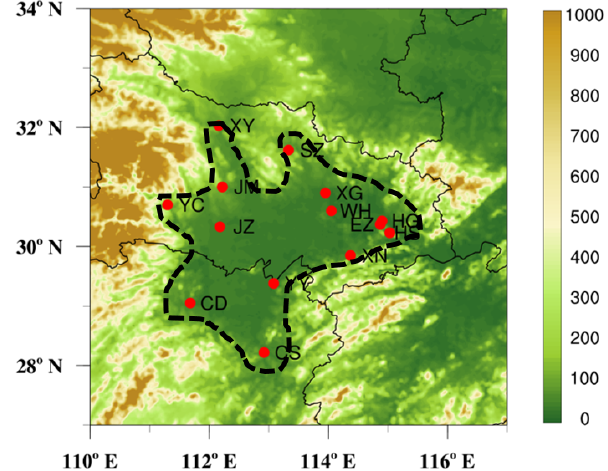
Figure 1. Topographical height (color contours, ma.s.l.) over the THB (outlined with black dashed line) with the locations of 14 sites (red dots) and the surrounding regions in central